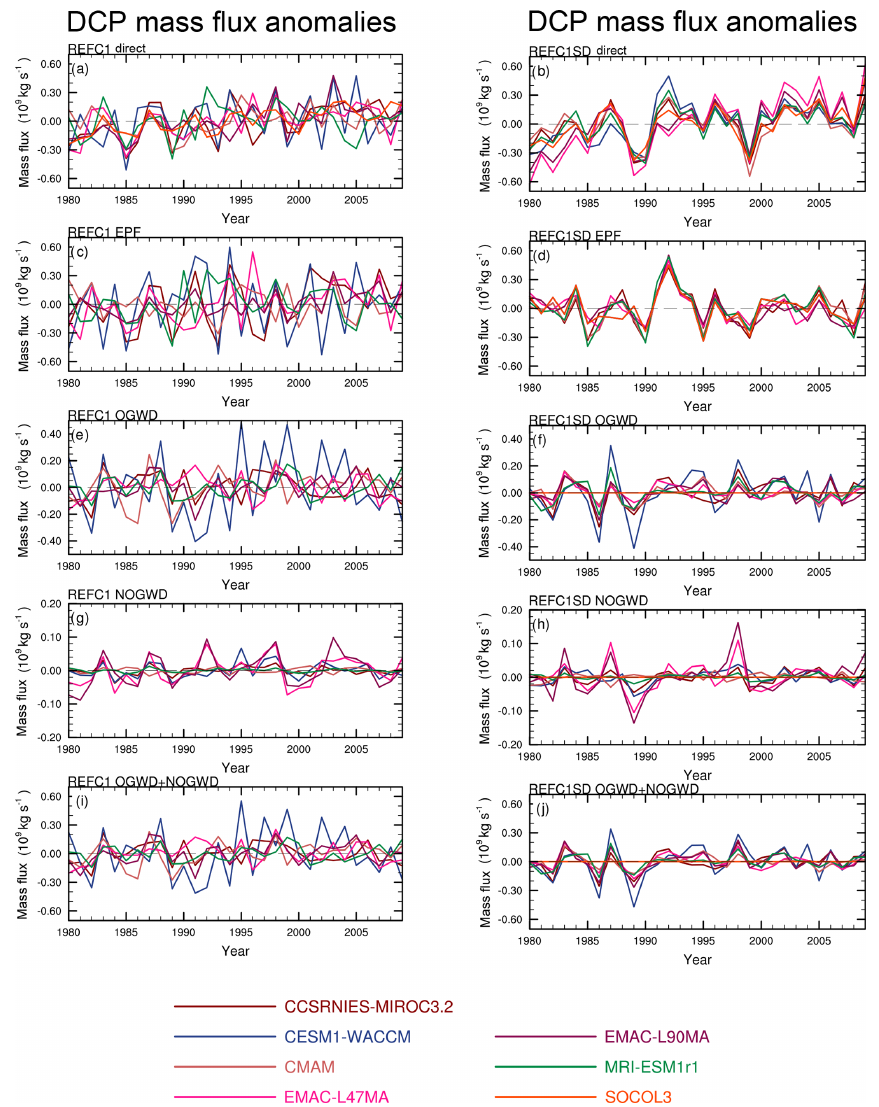
Figure 9. Time series of the annual tropical upward mass flux anomalies ( × 10 9 kgs − 1 ) calculated from (top to bottom) w ∗ (a, b) , and the downward control principle inferred contributions from resolved (EPFD) wave driving (c, d) , orographic gravity wave drag (OGWD) (e, f) , non-orographic gravity wave drag (NOGWD) (g, h) , and from the total parameterized (OGWD and NOGWD) gravity wave drag (i, j) for REF-C1 (left panels) and REF-C1SD (right